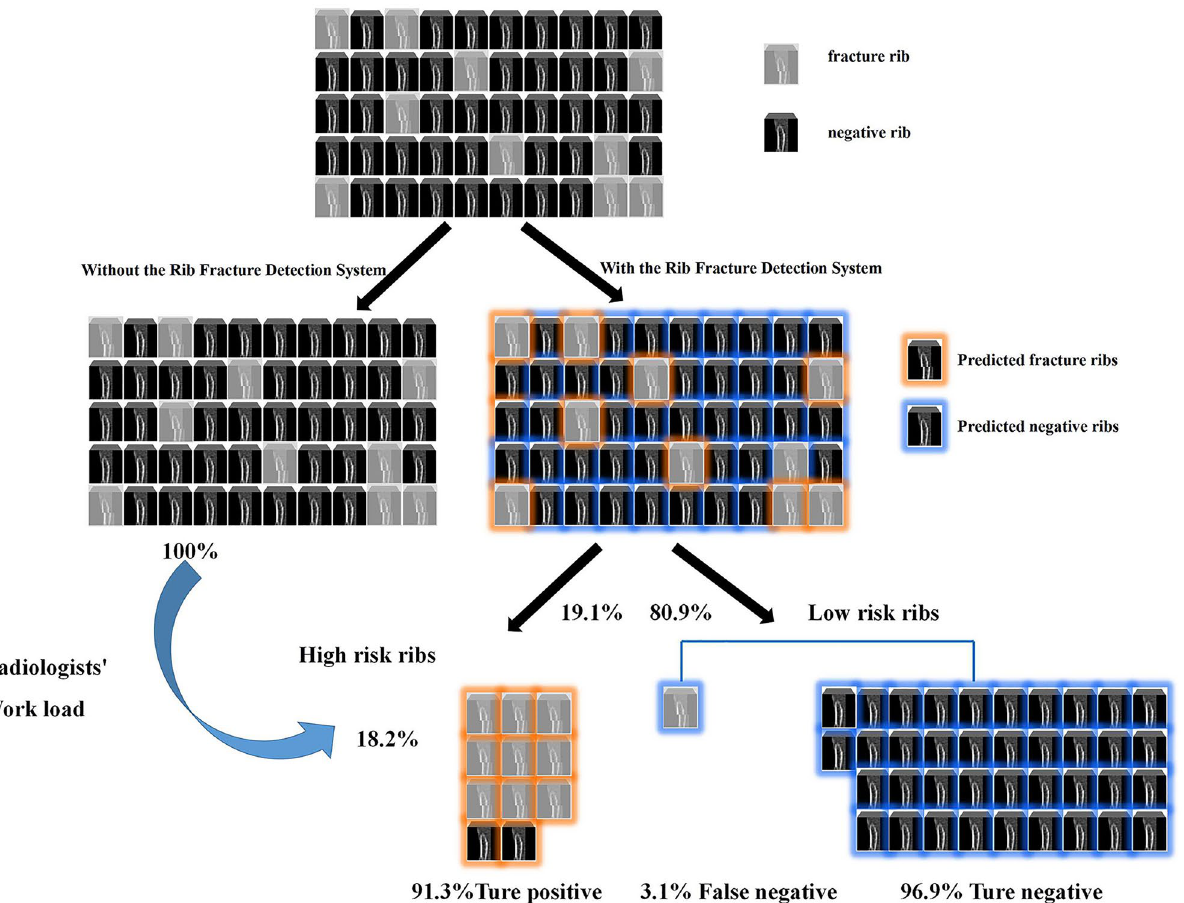
Figure 5. Impact of the Rib Fracture Detection System in clinical practice for patients with suspicion of rib fracture in the Department of Radiology. In a cohort of patients with suspected rib fractures who underwent chest CT investigation, radiologists should pay close attention to all of the ribs without the help of our model in order to look for 18.2% of the fractured ribs. Since 80.9% of the ribs were diagnosed as non-fracture ribs by this model with a 96.9% true-negative rate, it demonstrated high accuracy in identifying true non-fractured ribs by the constructed model. As a result, with the assistance of this deep learning model, radiologists only had to pay more attention to 19.1% of the ribs that were categorized as high-risk for fracture, which significantly reduced their workload in detecting rib